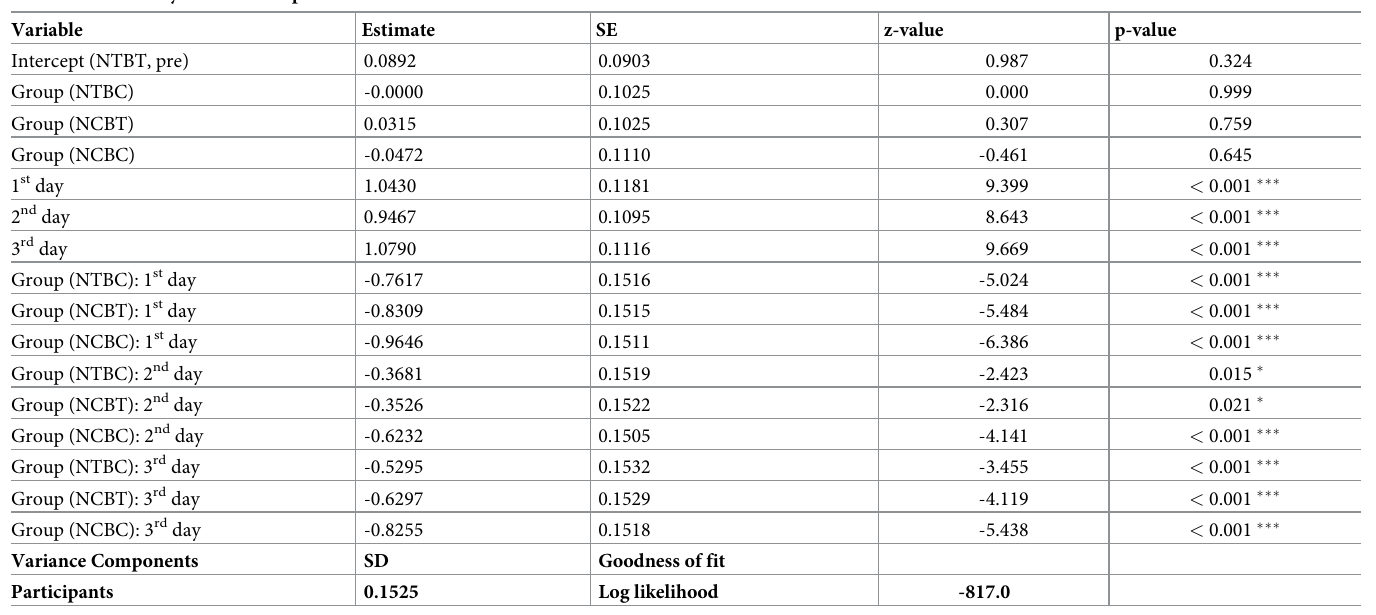
Table 1. Probability of correct responses in the BAD test.